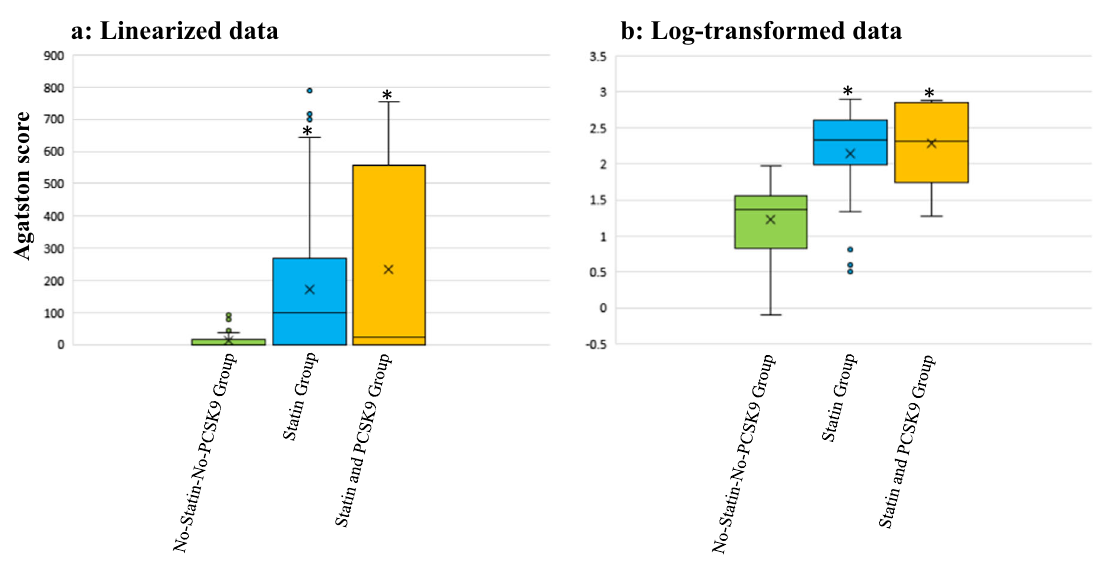
Fig. 1 a , b Coronary artery calcium score (Agatston score) of the three groups in the unpaired cross-sectional study ( n = 120). Data were expressed as the median and 10th – 90th percentile. The horizontal line inside the box is the median. Boxes represent the interquartile range (25th – 75th percentile). Whiskers represent the 10th – 90th percentile. The x marks in the box indicate the average. a Linearized data, b Log- transformed data. * P < 0.05 vs. no-statin-no-PCSK9 group by a one-way analysis of variance